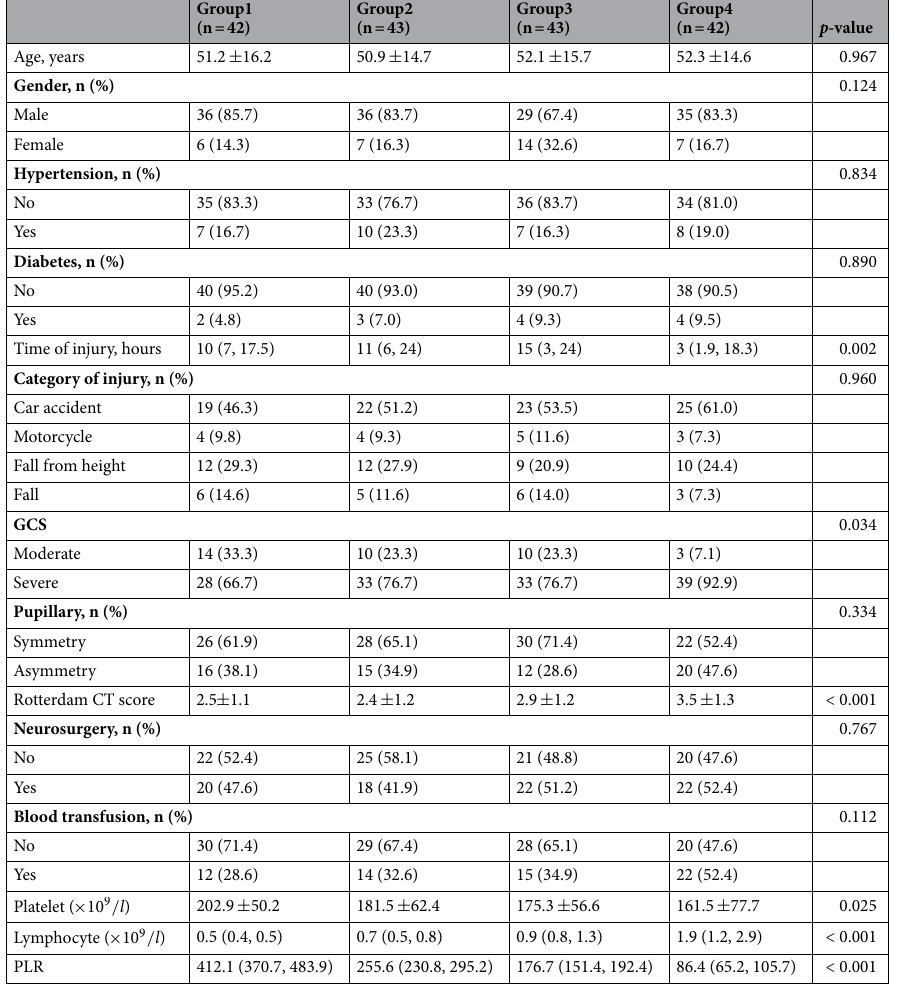
Table 2. The clinical characteristics of PLR